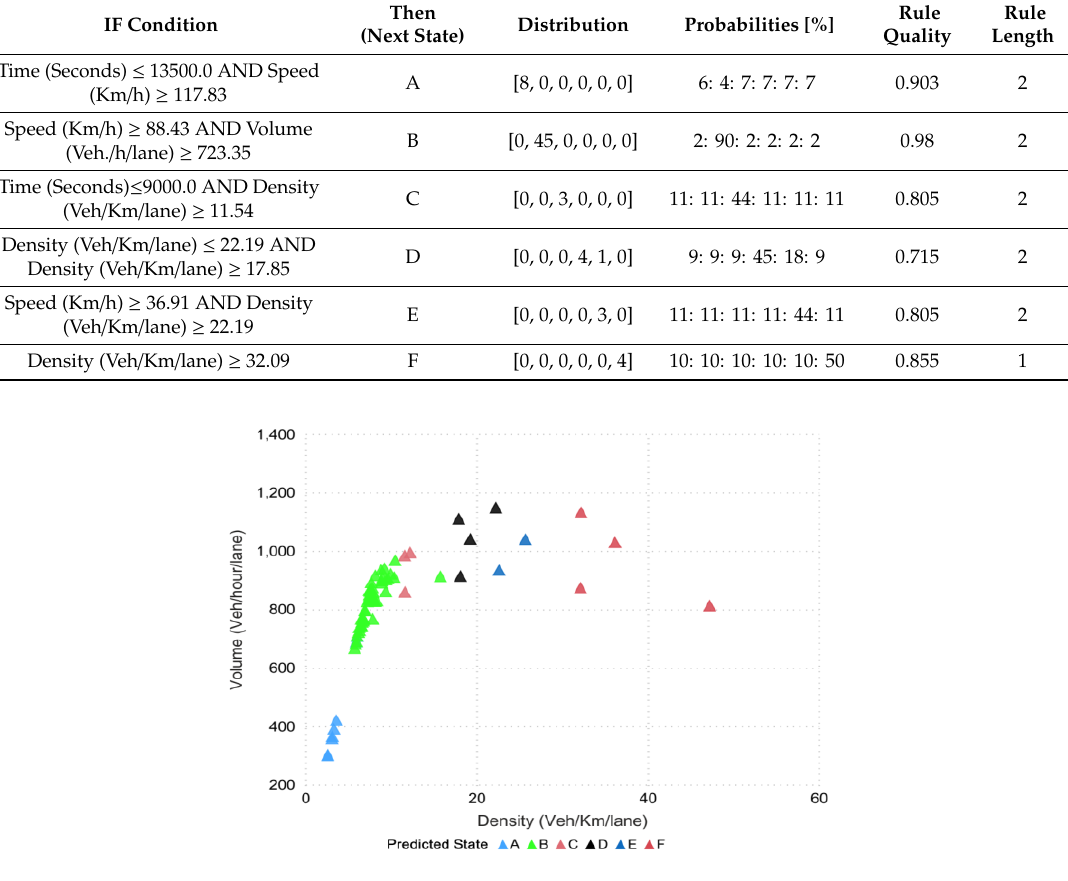
Figure 10. Predicted state for the next 15 min horizon. Table 1. Selected rules (for 15-min. prediction horizon) with rule quality.